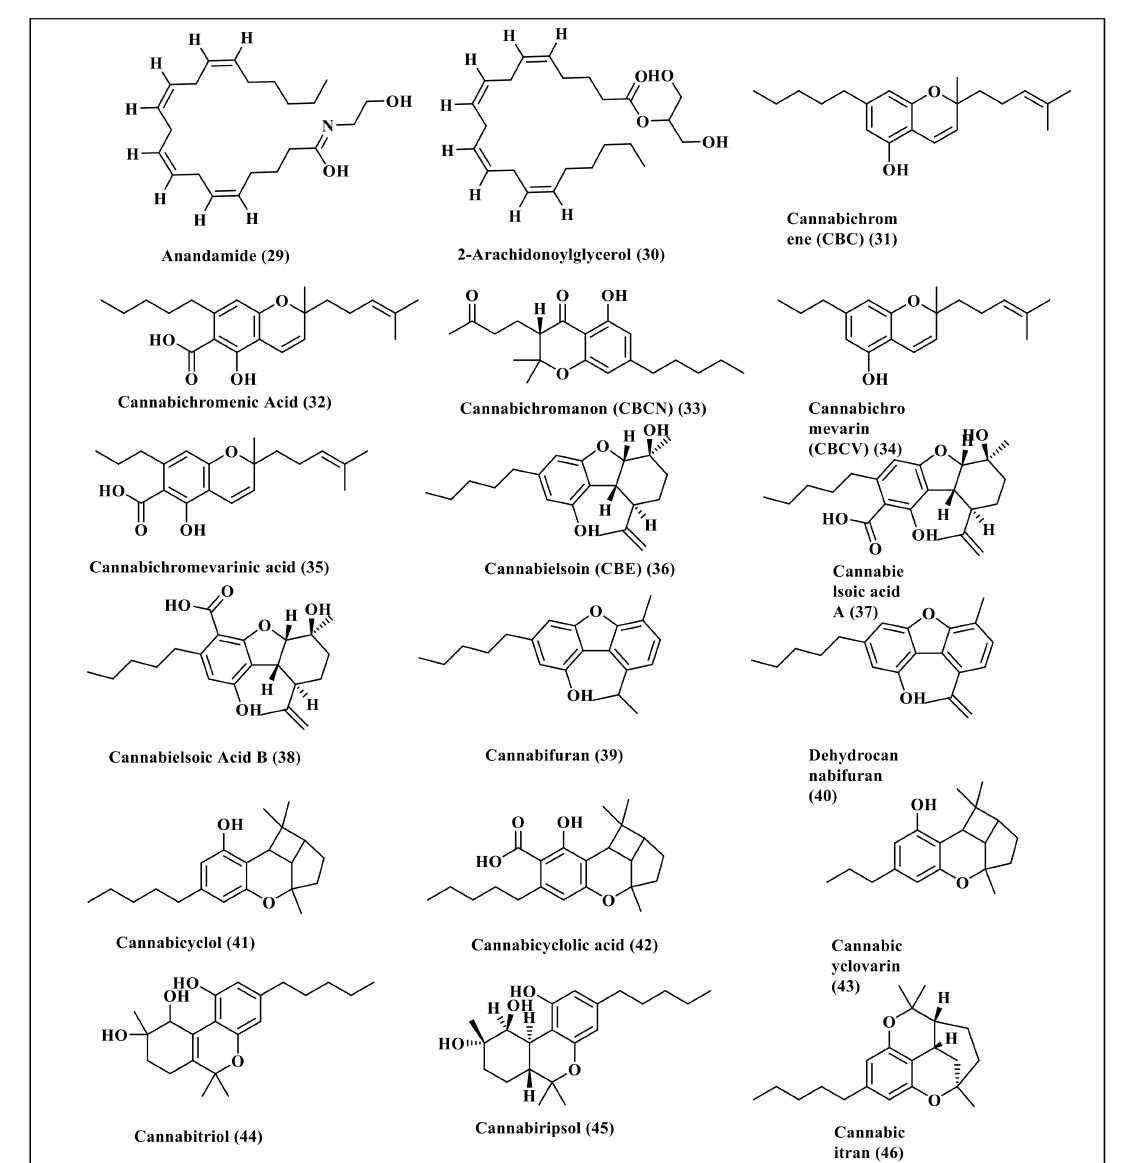
Figure 2. The chemical structures of some of the primary endocannabinoids and minor cannabinoids present in Cannabis sativa